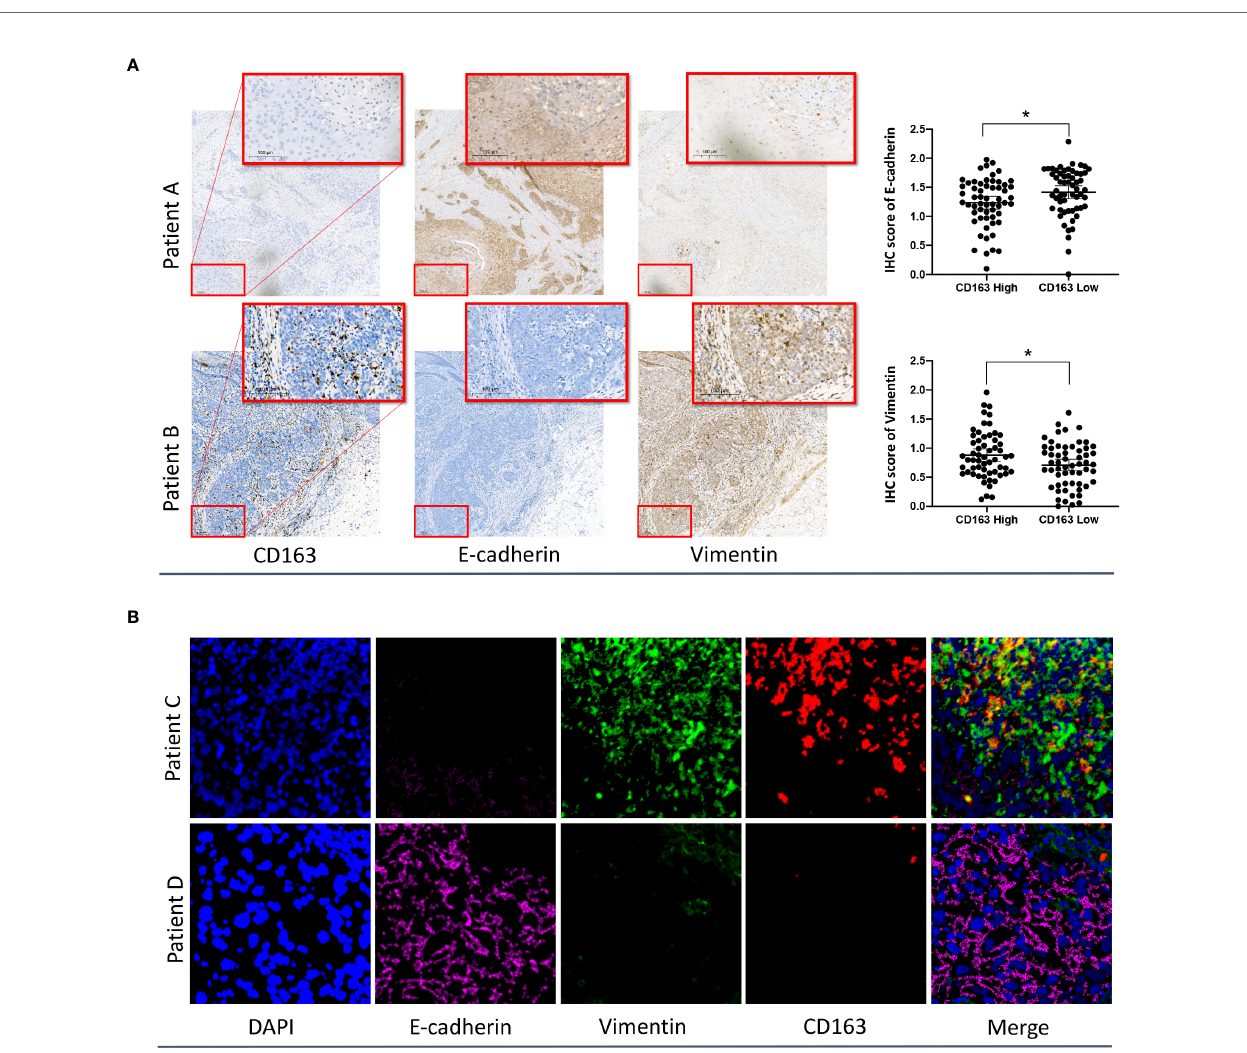
FIGURE 5 | IHC (A) and multiplexed immuno fl uorescence (B) analysis of ESCC samples con fi rmed the close relationship between M2 macrophages and the EMT phenotype. *p < 0.05 according to a